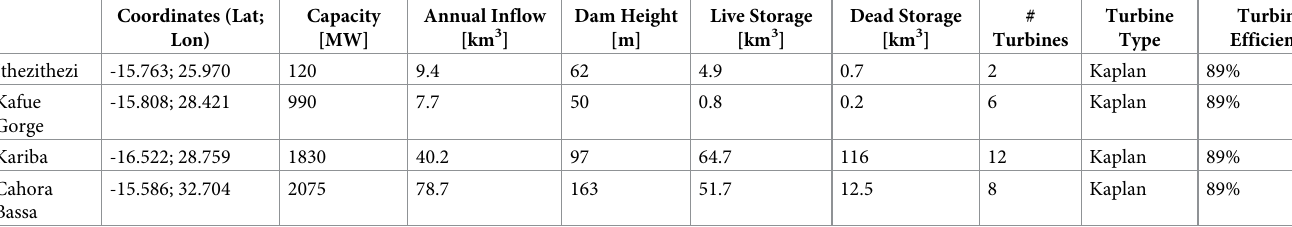
Table 1. Characteristics of the four considered dams. Sources: [101, 103, 104]. Coordinates (Lat;